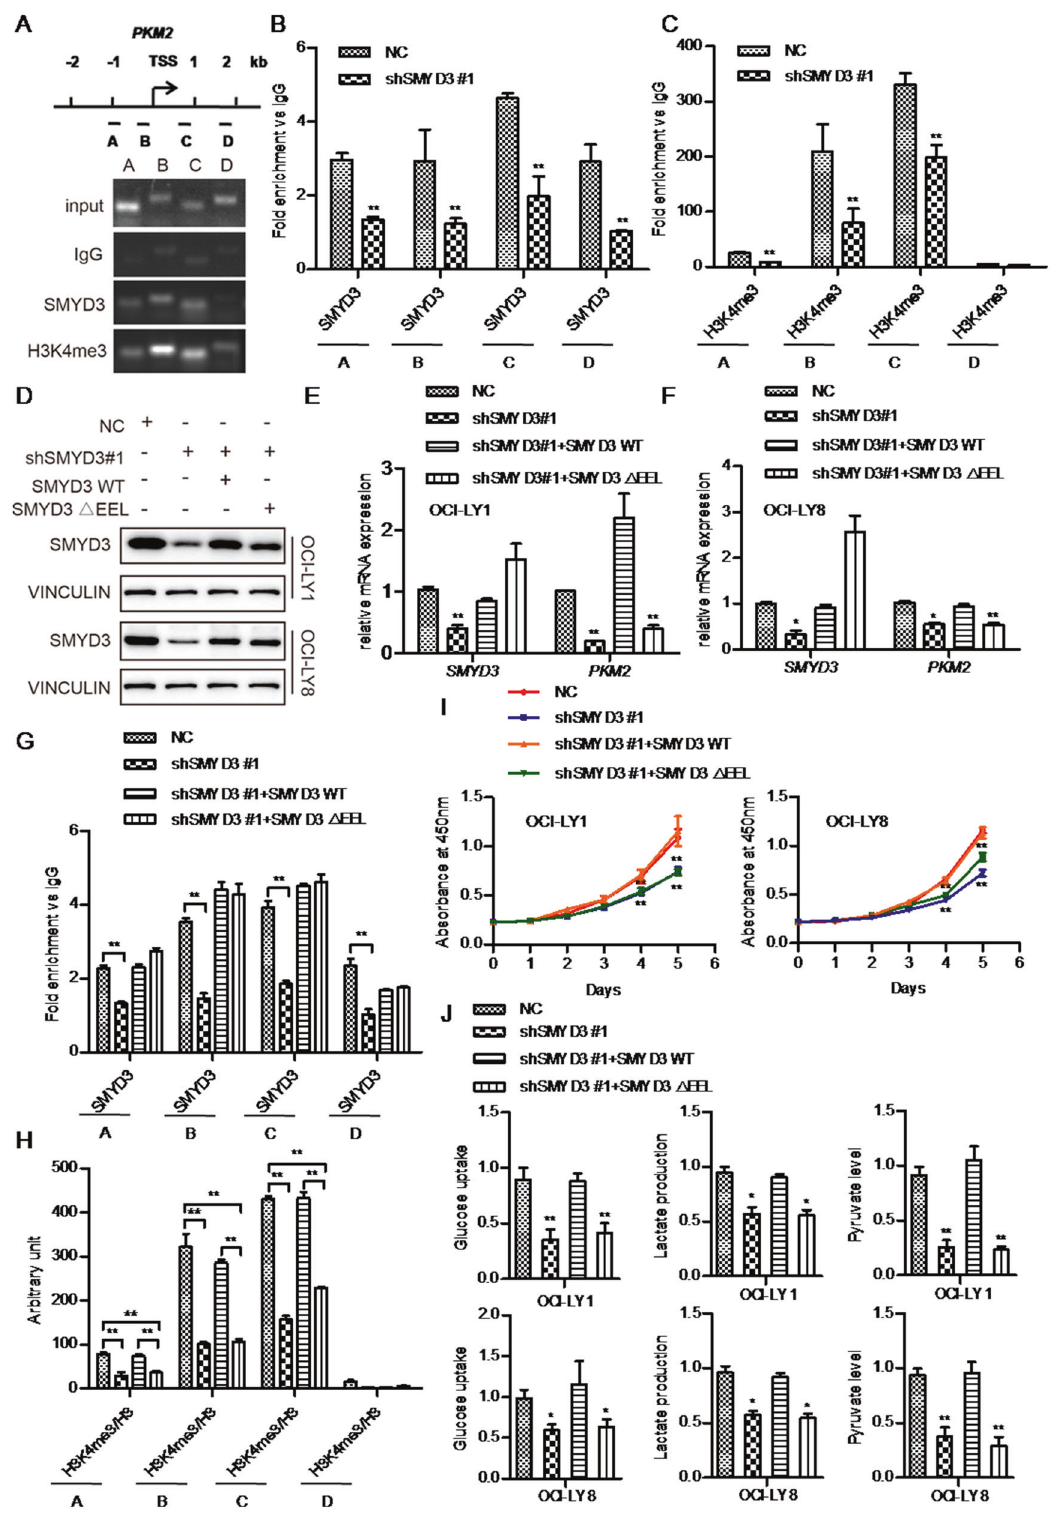
monomer or dimer modulated by allosteric regulation [16]. The present study demonstrated that SMYD3 inhibited the transcrip- tion of PKM2. The protein expression of PKM1 was very low in DLBCL tissue. Recent study has reported that the expression of PKM1 tends to be cancer-speci fi c and may have